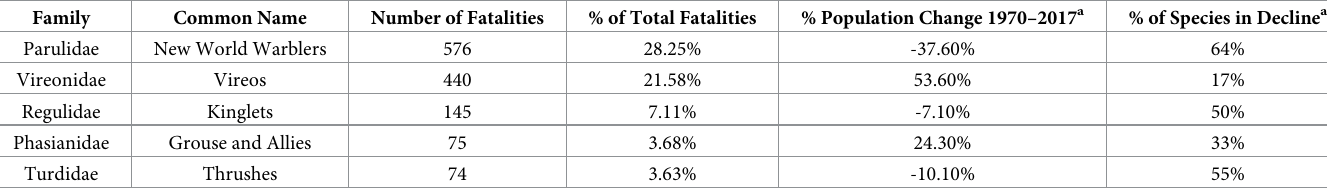
Table 2. Five most frequent families of bird mortality at wind turbines in the Northeastern US. Family